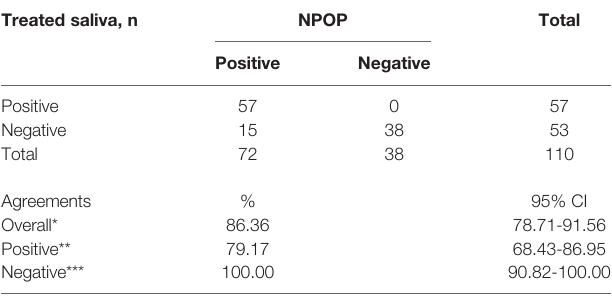
TABLE 2 | Validation of heated-only saliva as RNA-extraction free treatment. Treated saliva,